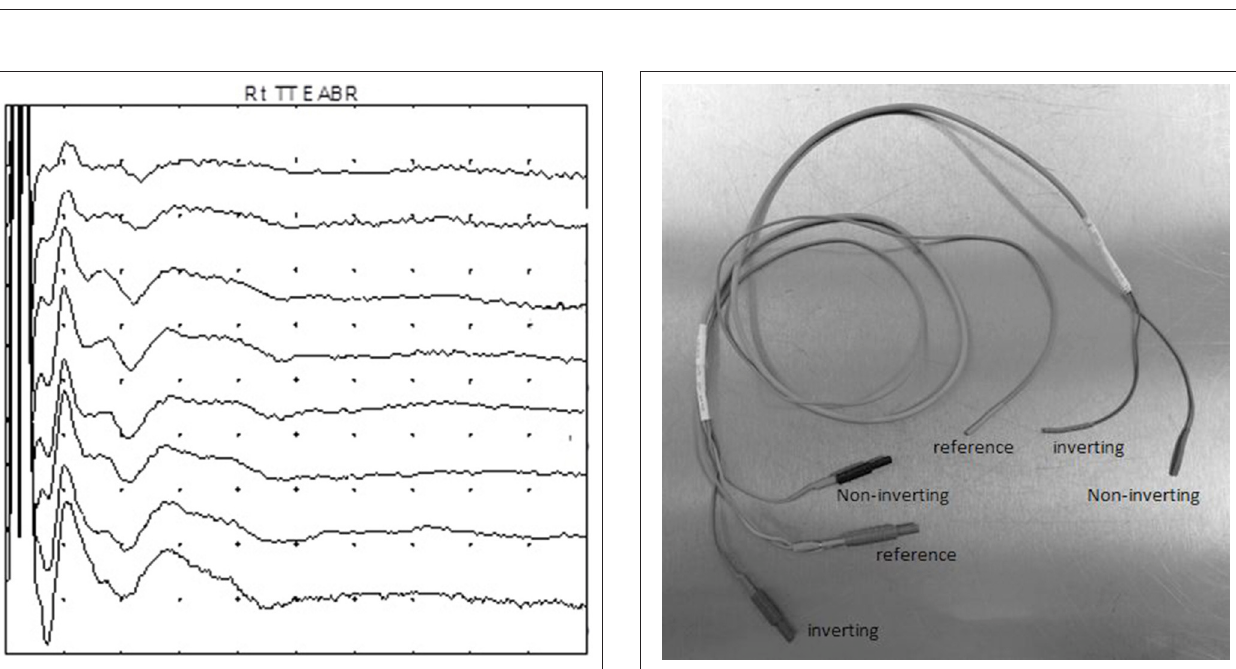
FIGURE 2 | Electrocochleography (ECochG) traces from an ear affected by auditory neuropathy.